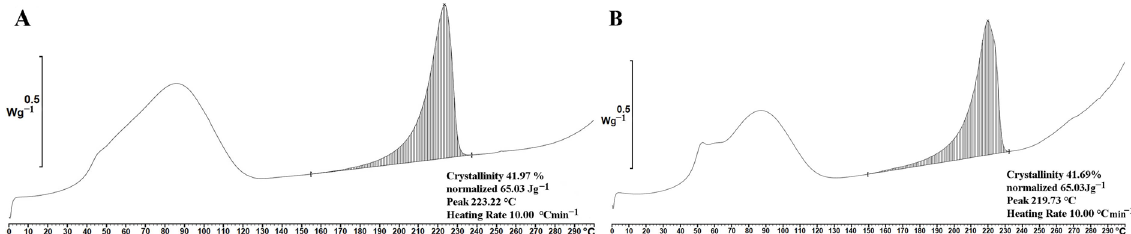
Figure 5. Crystallinity analysis (DSC) of PVA ( A ) and PVA_PL ( B ).